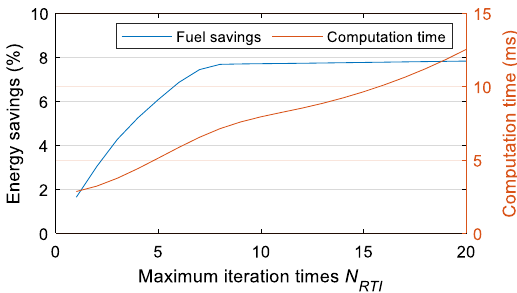
Figure 16. Results of the sensitivity analysis.